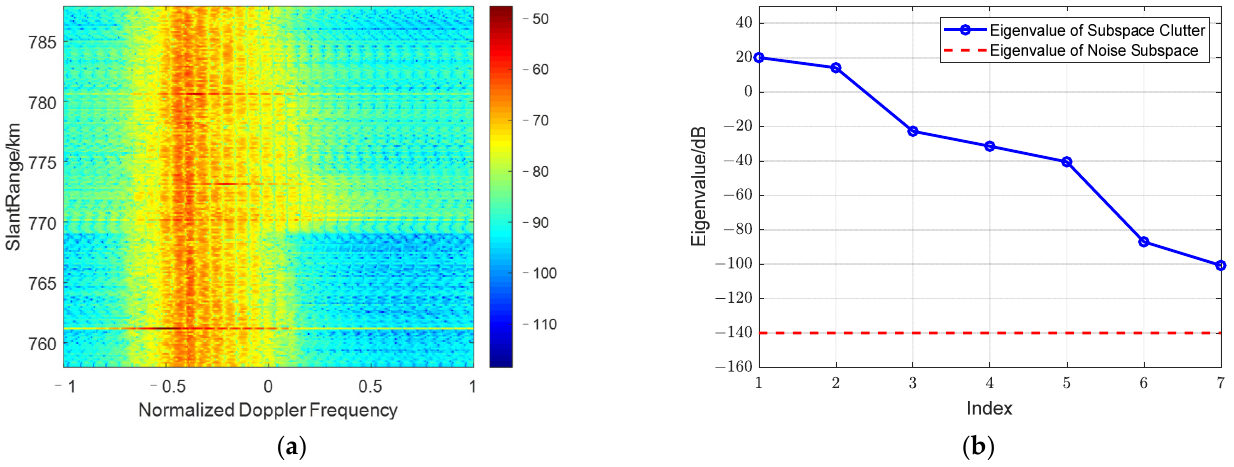
Figure 11. ( a ) The range-Doppler output power spectrum after using method 3.b; ( b ) The eigenvalue spectrum of the dimensionality reduction CCM.